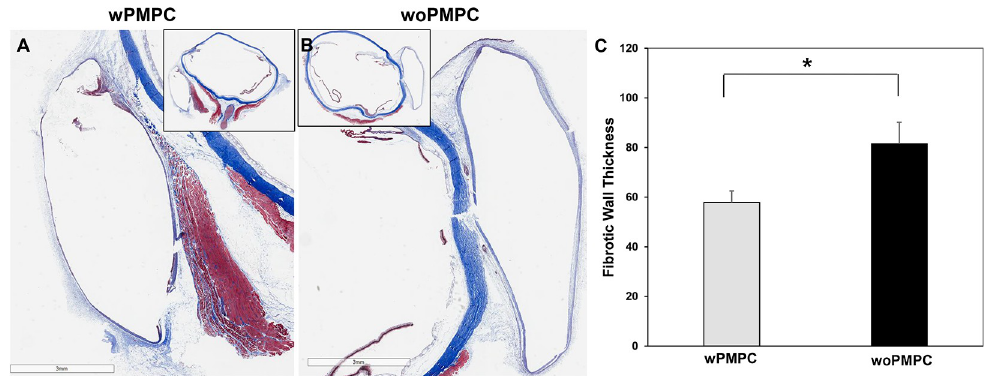
Fig 6. Comparison of overall thickness of the fibrotic wall. (A) The main image shows 8 × magnified image of the fibrotic wall region in the thumbnail image. The fibrotic capsule around the PMPC-coated implant is stained modest blue. (B) The fellow eye of the same rabbit with PMPC-uncoated implant. Scale bars: 3 mm. (C) In the wPMPC group, the average fibrotic wall thickness was significantly thinner than that in the woPMPC group (p = 0.025). Data are shown as the mean ± standard deviation for each group. wPMPC, Ahmed glaucoma valve coated with PMPC; woPMPC, Ahmed glaucoma valve without PMPC-coating.